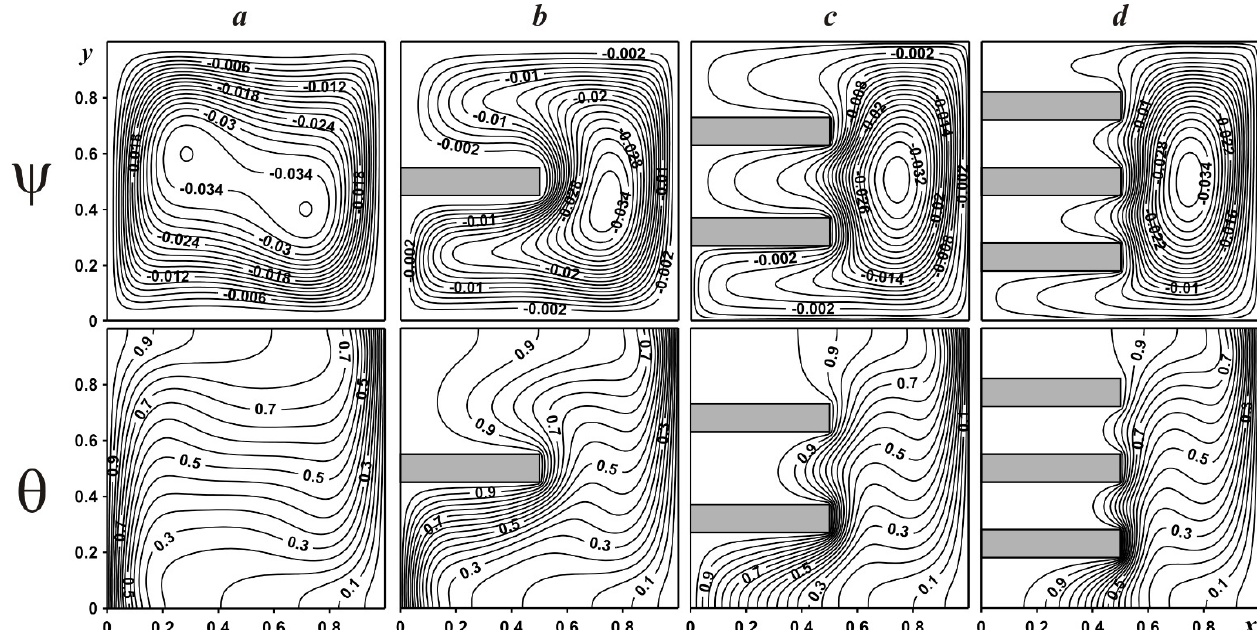
Figure 3. Streamlines and isotherms in a cavity with solid fins: without fins ( a ); one fin ( b ); two fins ( c ); three fins ( d ).